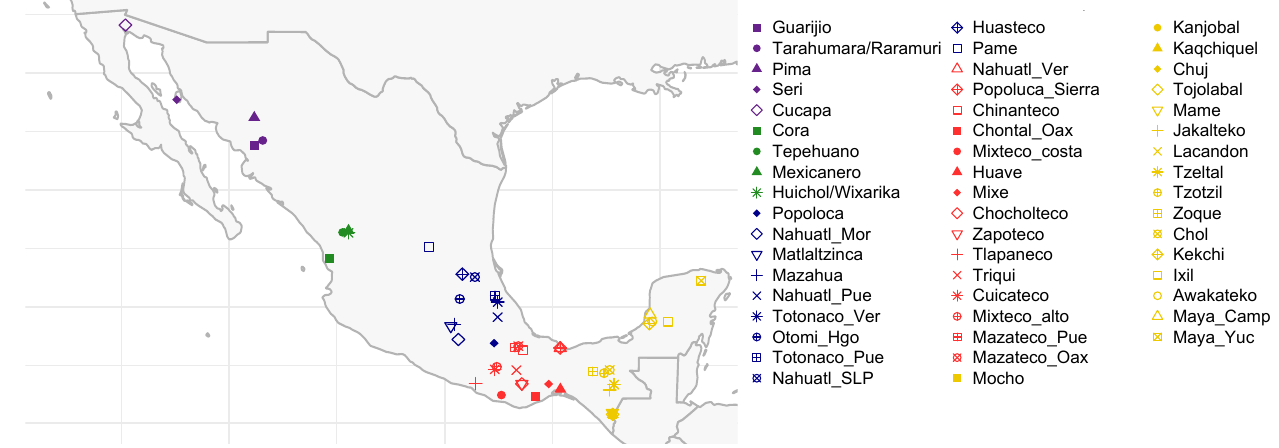
Figure 1. Geographical distribution of the 53 Mexican Indigenous communities included. Dot shapes denote the ethnic group and colors their assigned geographic region. Purple: North, green: Northwest, blue: Center, red: South, and yellow: